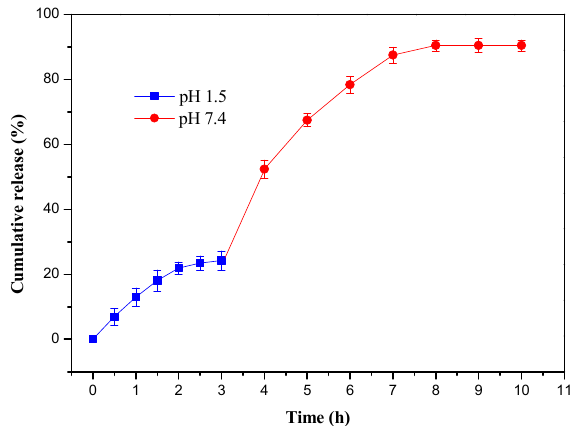
Figure 7. Acetylsalicylic acid release performance of gel-3 in pH 1.5 bu ff er solution for 3 h followed by the drug’s release in pH 7.4 for 10 h at 37 °C.